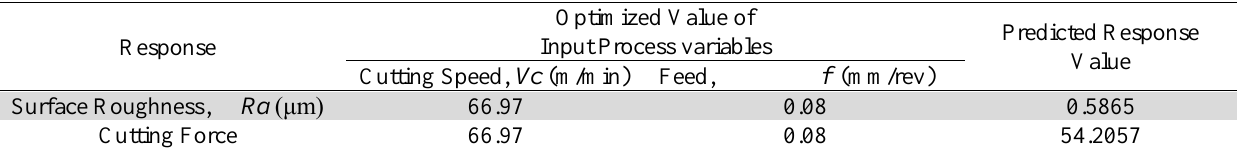
Optimization Result Response